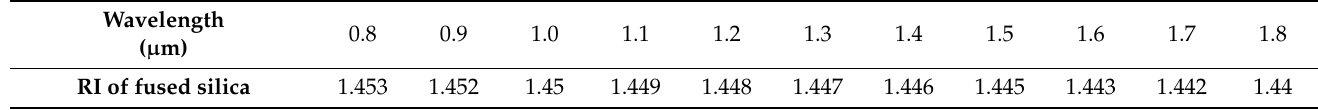
Table 1. Refractive index of fused silica for different operating